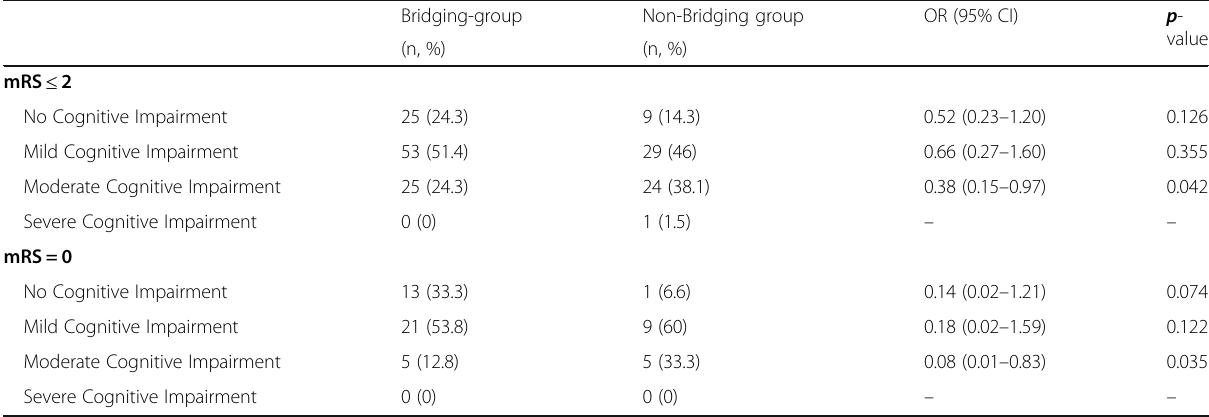
Table 3 Severity of Cognitive Impairment Bridging-group Non-Bridging group OR (95%